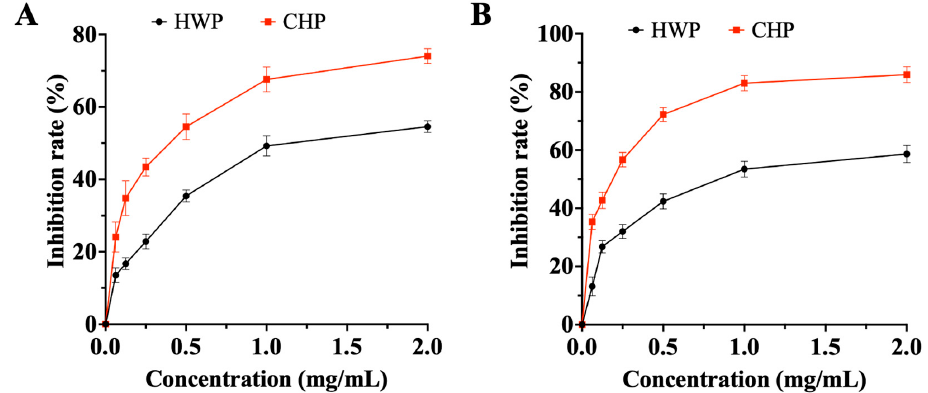
Figure 4. The inhibitory effects of TPs on α -amylase ( A ) and α -glucosidase ( B ).